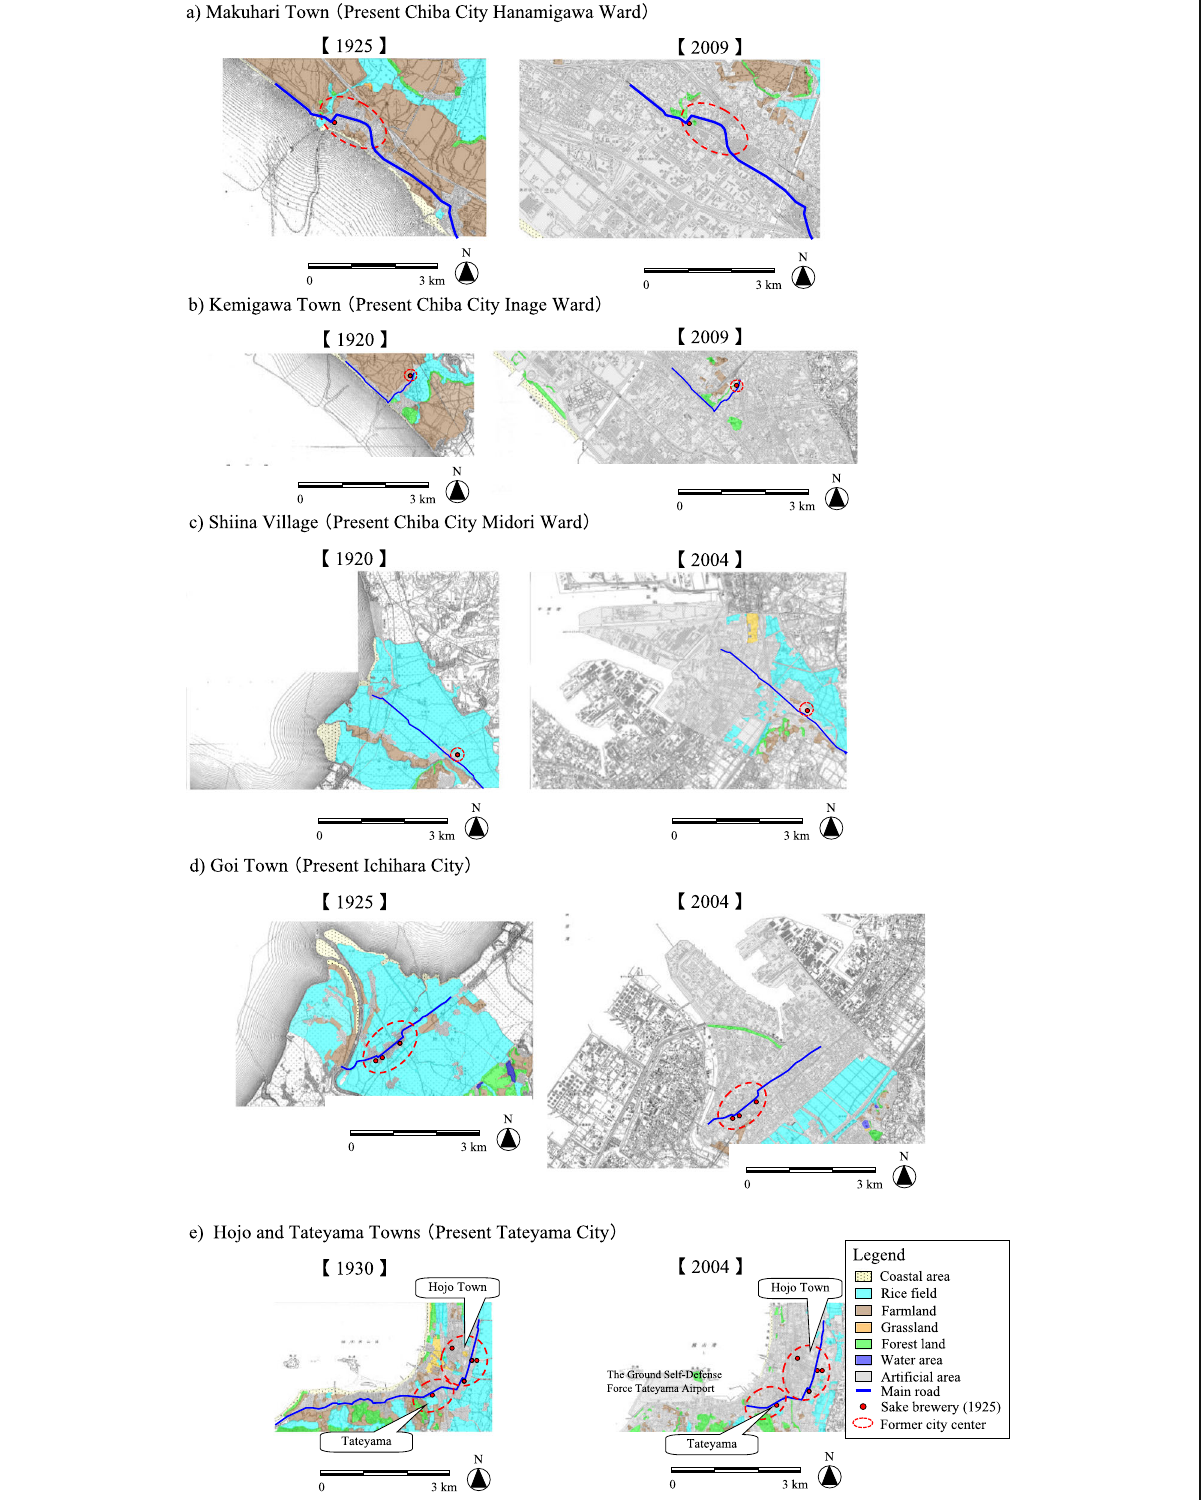
Fig. 7 Land use in the 1920s and 2000s. Base maps by the Geospatial Information Authority of